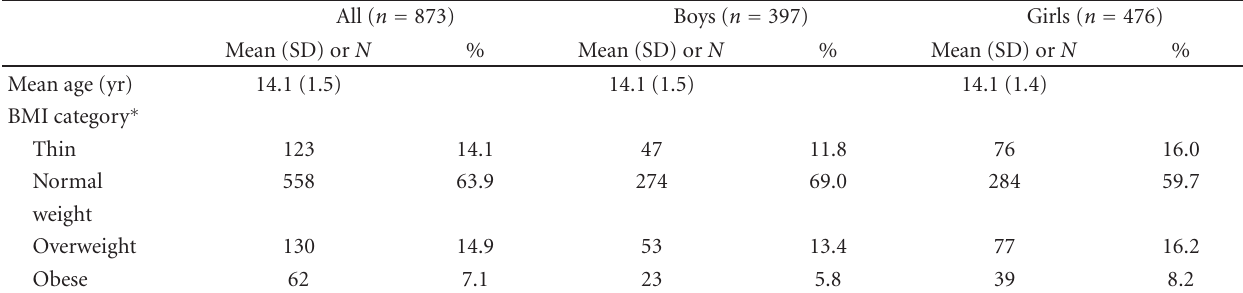
Table 1: Selected characteristics of the participants.